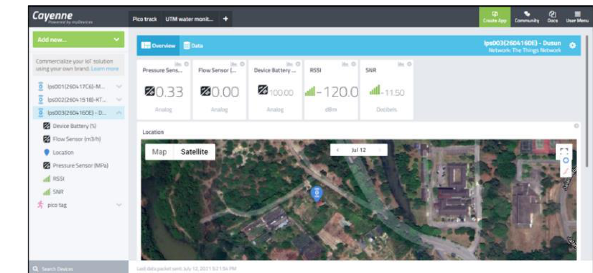
Figure 10. Dashboard for UTM water monitoring.